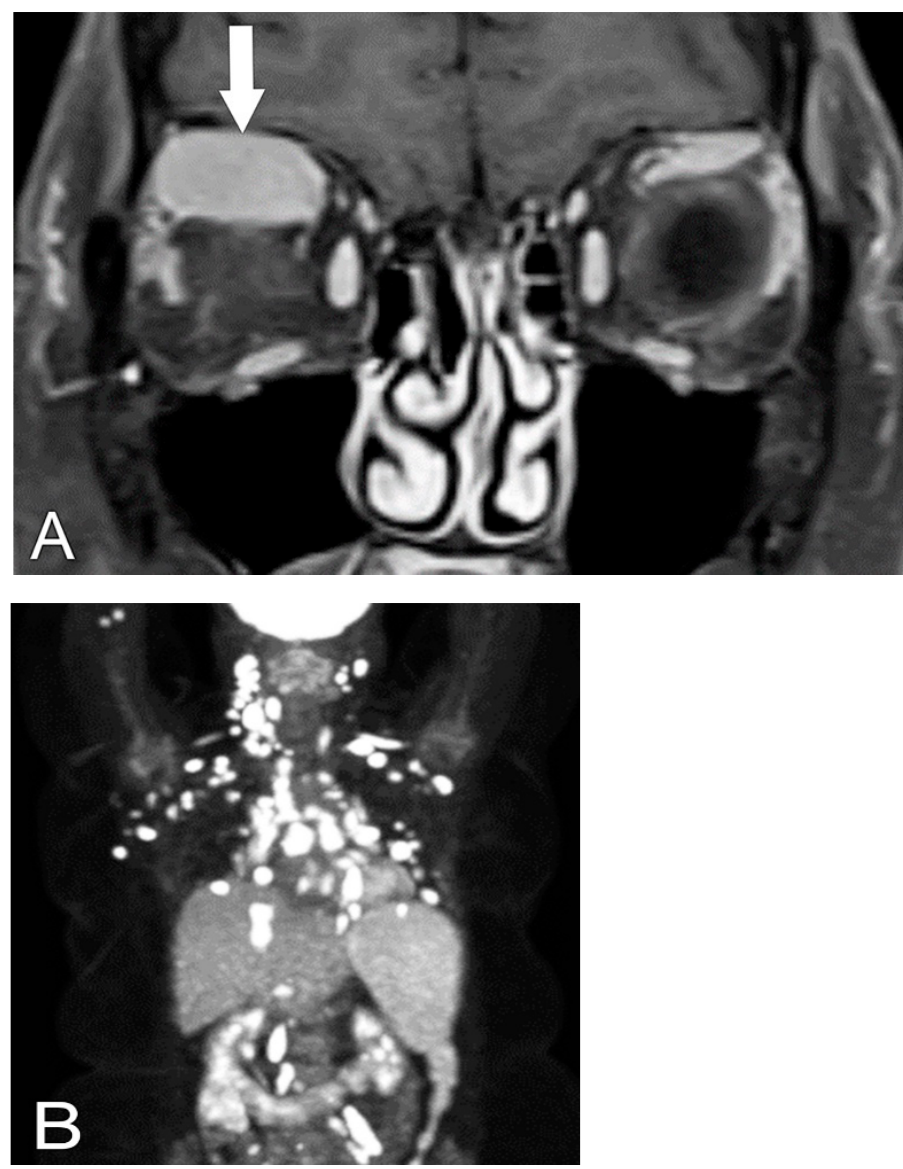
Figure 7. Lymphoma. ( A ) Coronal T1 post-contrast MRI sequence shows a homogeneously enhanc- ing, well-circumscribed mass involving the right superior rectus–levator muscle complex (arrow). ( B ) Coronal PET image shows diffuse adenopathy throughout the neck and body. Orbital metastasis commonly involves the EOMs. Approximately 60% of EOM metas- tases cause EOM enlargement [70]. Additionally, about 58% of patients with orbital metas- tasis have already been diagnosed with a primary tumor. These primary tumors are most commonly gastrointestinal tumors, breast cancer, or cutaneous melanoma. While GED imaging findings tend to show diffuse infiltration, EOM metastasis findings show a nodular pattern (Figure 8) [71,72]. The number of EOMs affected can vary, and there may be a delay in time from the diagnosis of the primary disease. Other findings may include lesions in the bony orbit or the intracranial compartment